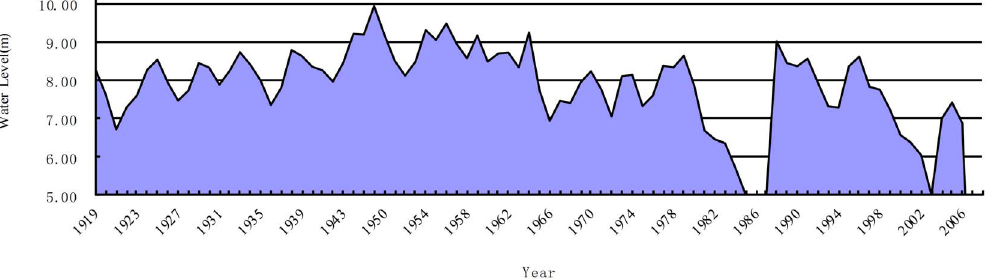
Figure 2. Water levels from 1919 to 2009 in the Baiyangdian wetland. The water level varied in the past 30 years. The wetland dried up from 1983 to 1988 because of deceasing environmental flows.